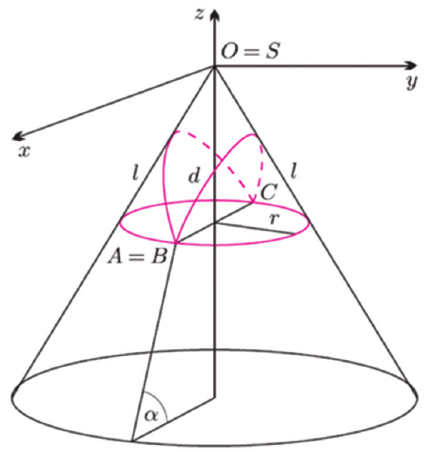
Fig. 6. The conical parallel of latitude circle and its diameters (Kopacz 2010)